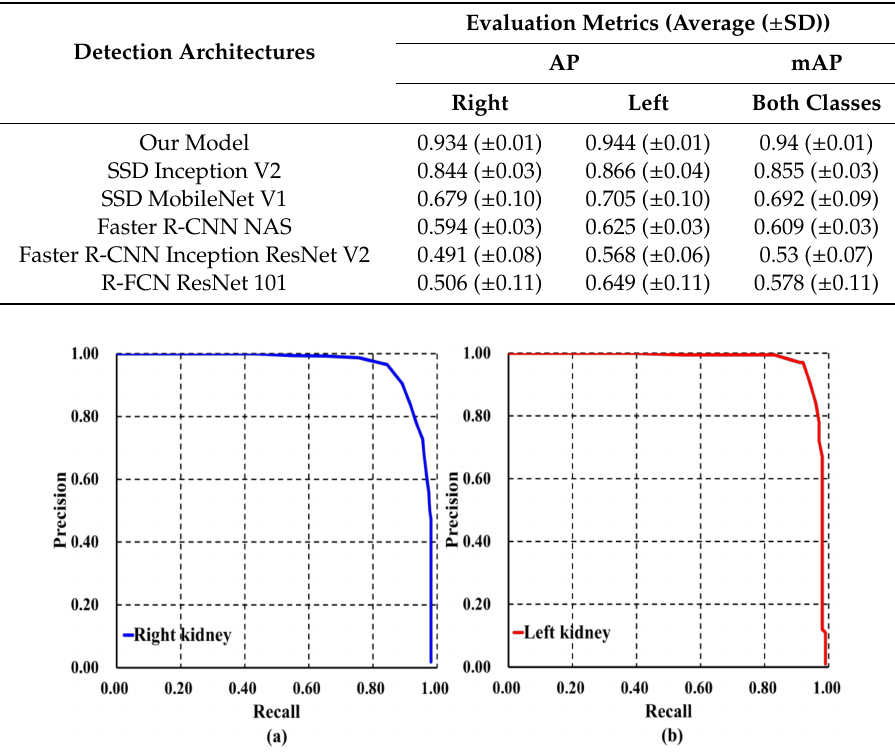
Table 3. Comparison of Average Precision (AP) and mean Average Precision (mAP) with other architectures on image-wise testing.